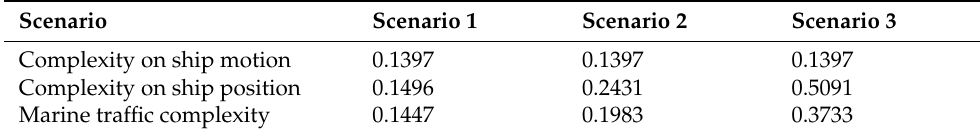
Table 2. The results of the second simulated case study.